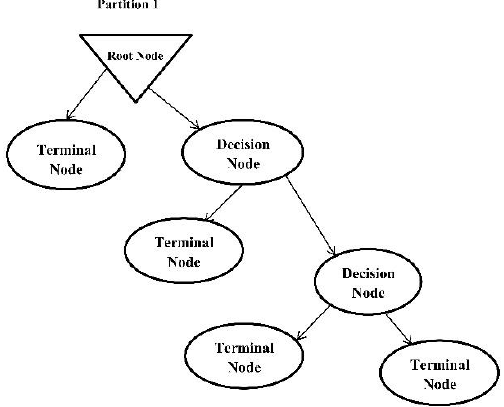
Figure 4. Schema of a classification decision